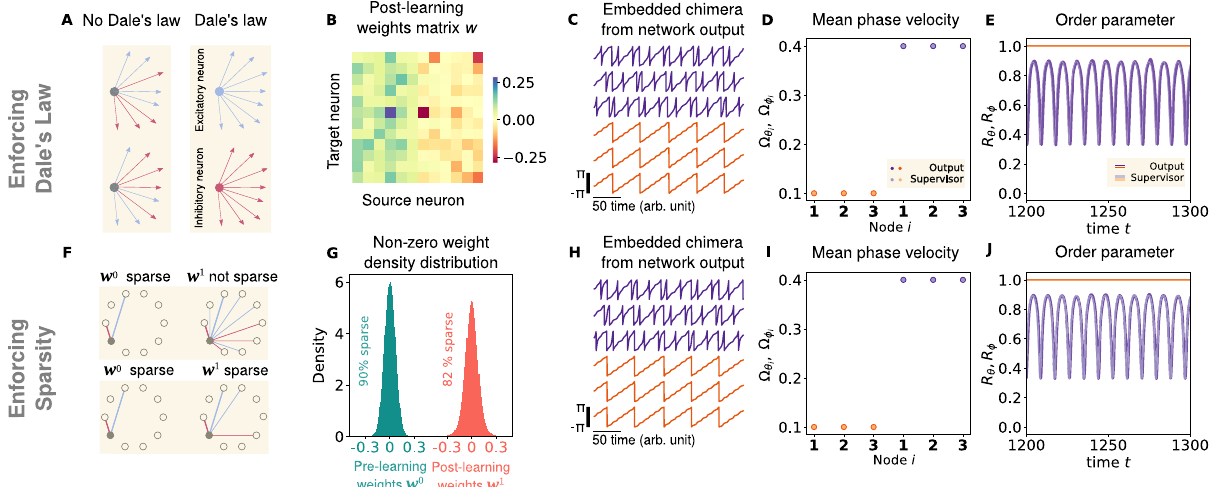
Fig. 3 FORCE method robustness: enforcing different constraints. A Dale's law schematic representation. Blue and red edges (dark and light gray for b/w printing) indicate respectively excitatory (positive) or inhibitory (negative) connections. Edge thickness represents the weight of each connection. B Fraction of the post-learning weight matrix ω 1 = ω 0 + η d ⊤ , which respects Dale's law: an excitatory (inhibitory) neuron (columns in the plotted matrix) will only excite (inhibit) its connections, regardless of the neuron target type. C Embedded chimera from network output subject to Dale's law. D Mean phase velocity pro fi le for the embedded chimera (bright colors) obtained from the network output subject to Dale's law and for the supervisor (light colors). E Order parameter trajectory for the embedded chimera (bright colors) obtained from the network output subject to Dale's law and for the supervisor (light colors). F Schematic representation of sparsity enforcement in ω 1 . Blue and red edges (dark and light gray for b/w printing) indicate respectively excitatory (positive) or inhibitory (negative) connections. Edge thickness represents the weight of each connection. G Density distribution for the non-zero weights for ω 0 and ω 1 , sparsity is decreased only by 8%. H Embedded chimera from network output subject to sparsity. I Mean phase velocity pro fi le for the embedded chimera (bright colors) obtained from the network output subject to sparsity and for the supervisor (light colors). J Order parameter trajectory for the embedded chimera (bright colors) obtained from the network output subject to sparsity and for the supervisor (light